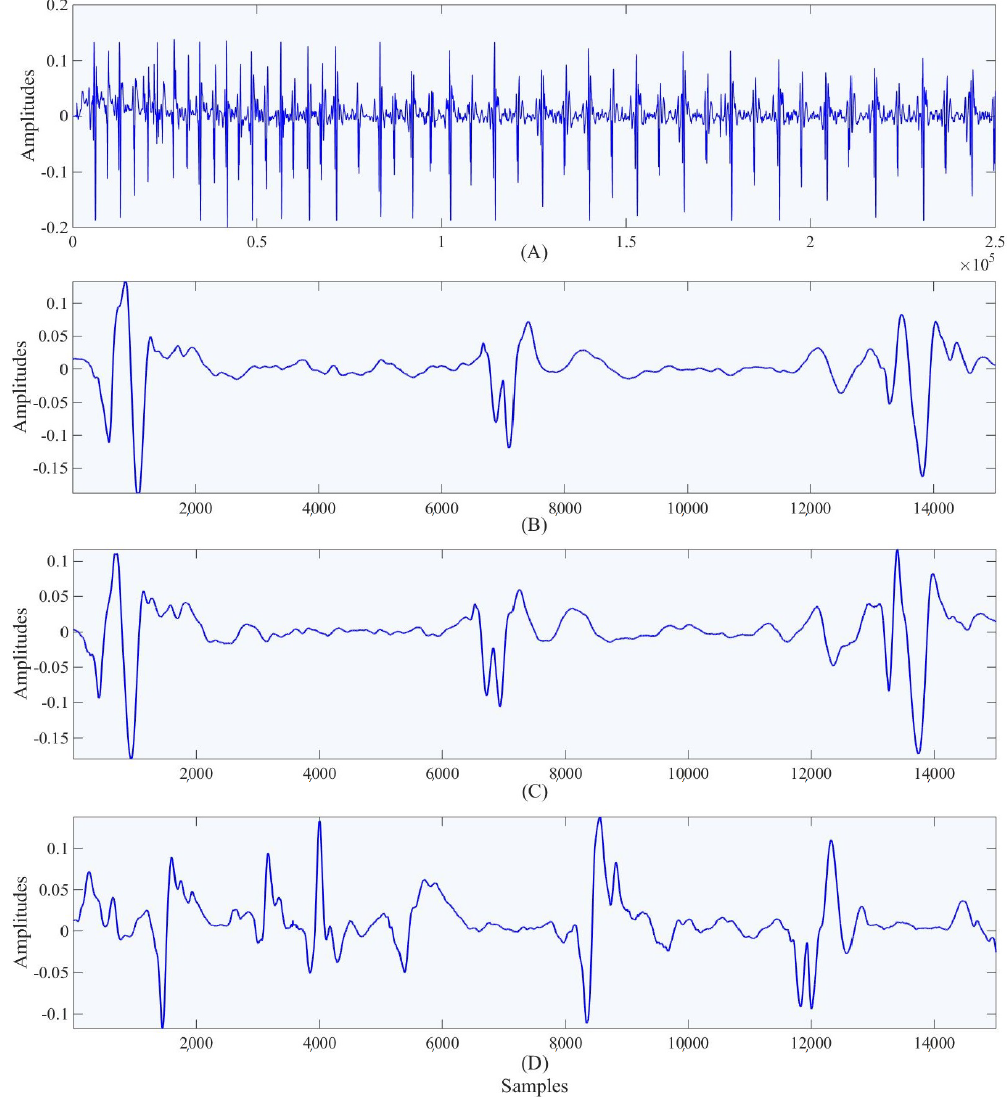
Figure 4. Illustration of Phonocardiography (PCG) signal. Panel ( A ) shows the de-noised data, panel ( B ) shows the selected window of the data, panel ( C ) shows the best window with the distance less than 0.005 from the selected window and panel ( D ) shows a worse window which has distance more than 0.005 from the selected